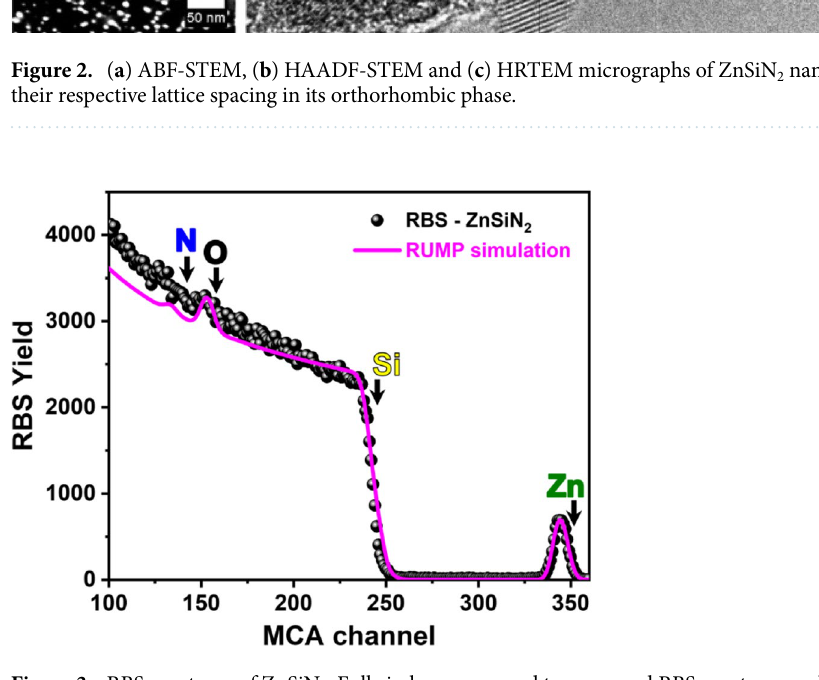
Figure 3. RBS spectrum of ZnSiN 2 . Full circles correspond to measured RBS spectrum and line corresponds to the RBS simulation performed by RUMP code 44